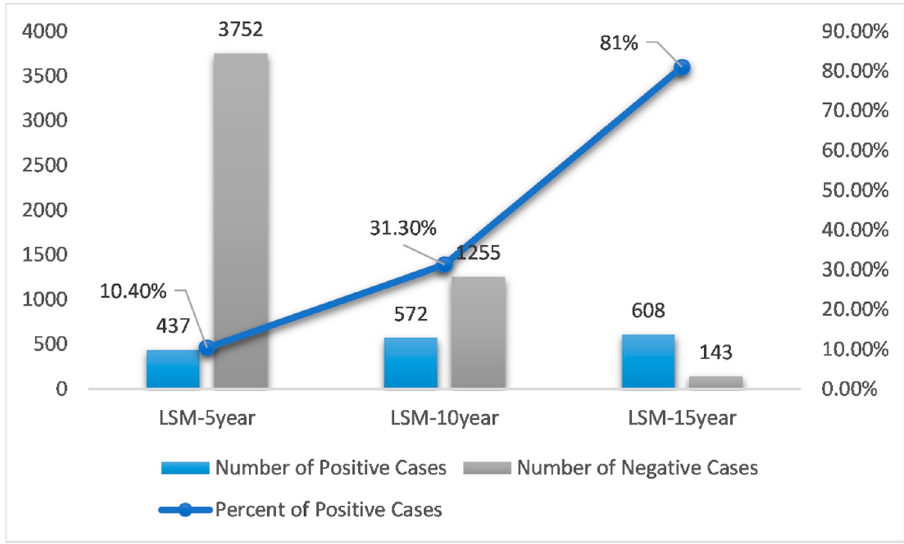
Figure 7. A comparison of the data imbalance status of LSM-5 year, 10 year, and 15 year datasets (LSM: Lynn Sage Dataset for Metastasis).